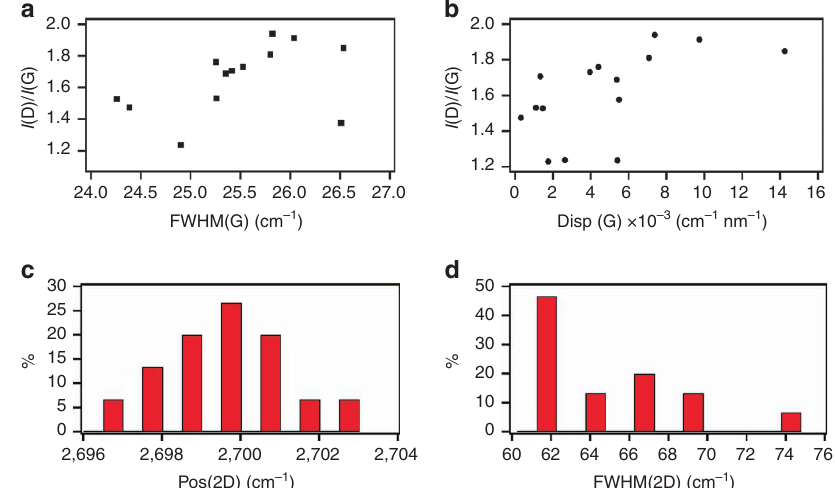
Figure 3 | Raman analysis of graphene/4-(decyloxy)azobenzene films. I (D)/ I (G) as a function of ( a ) FWHM(G) and ( b ) Disp(G). Distribution of ( c ) Pos(2D) and ( d )